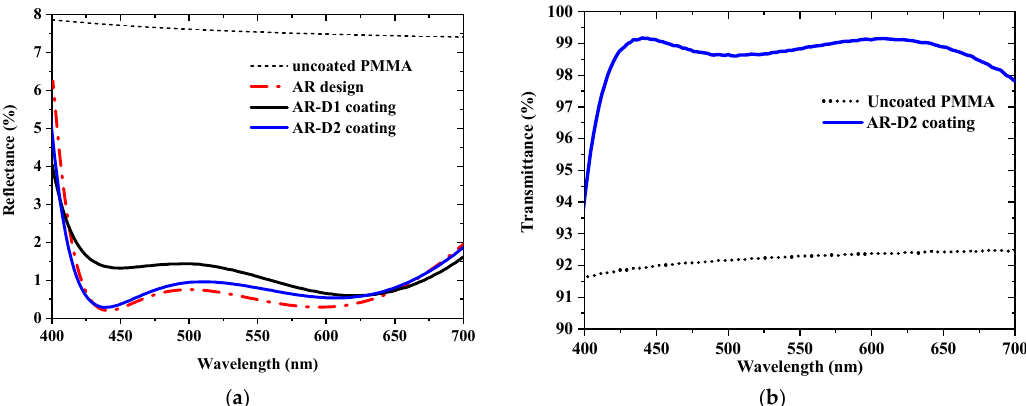
Figure 3. ( a ) Reflection spectra of AR design (red-dashed curve) and double-sided AR coated PMMA samples, i.e., AR-D1 (black solid curve) and AR-D2 (blue solid curve). Reflectance of uncoated PMMA substrate (dotted line) is given for comparison. ( b ) Transmittance spectra of bare and double-sided AR coated PMMA sample.